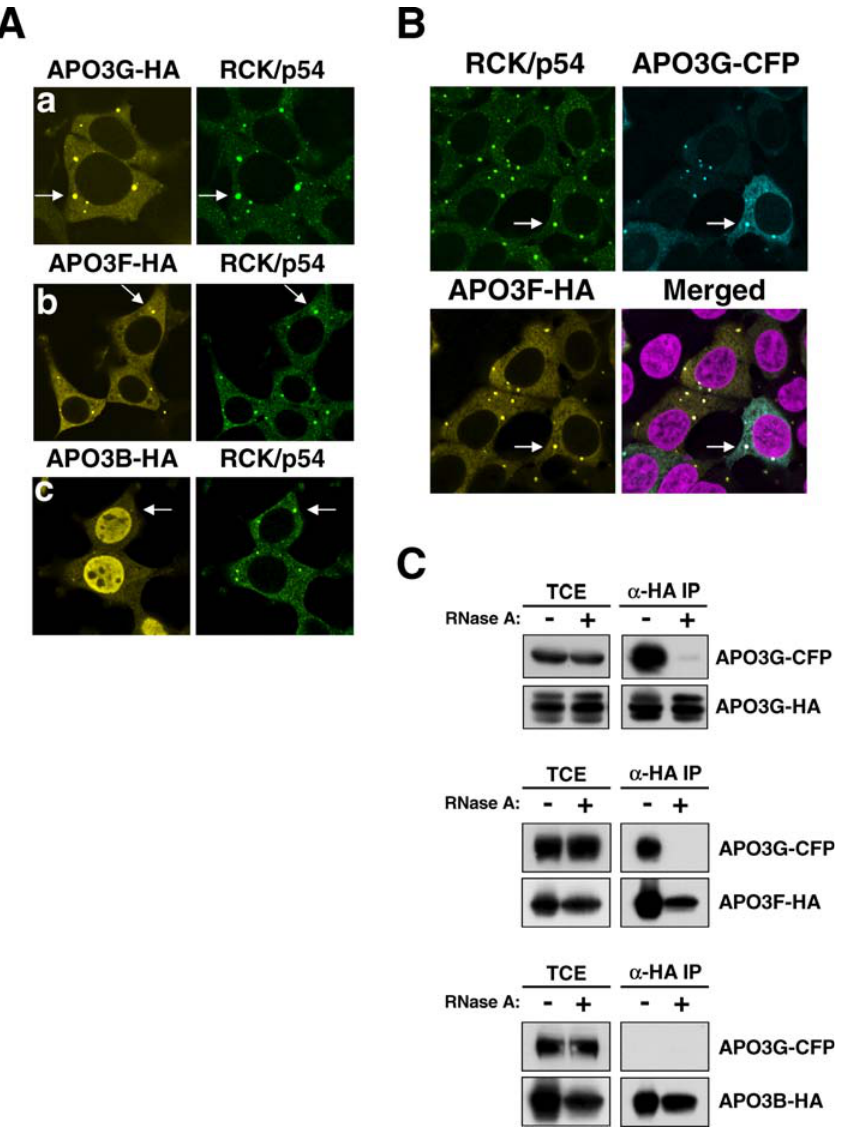
Figure 4. Potent Anti–HIV-1 Activity of APOBEC3 Proteins Correlates to P-Body Localization (A) Subcellular localization of endogenous RCK/p54 and APO3G-HA (a), APO3F-HA (b), or APO3B-HA (c) in 293T cells. Endogenous RCK/p54 was detected through indirect immunostaining with an antibody against RCK/p54 and APOBEC3 proteins with an antibody against the HA epitope. Arrows point to P-bodies. (B) Subcellular localization of endogenous RCK/p54, APO3G-CFP, and APO3F-HA in 293T cells. RCK/p54 was detected through indirect immunostaining with an antibody against RCK/p54, APO3F-HA with an antibody against the HA epitope, and APO3G-CFP was detected by direct CFP fluorescence. The cells were also stained with Hoechst 33258 to visualize nuclei and the images were digitally merged to highlight regions of colocalization, which appear white in the merged image. Arrows point to P-bodies. (C) RNA-dependent interaction of APOBEC3G and APOBEC3F. Total cell extracts from 293T cells coexpressing APO3G-CFP and APO3G-HA (top panel), APO3G-CFP and APO3F-HA (center panel), or APO3G-CFP and APO3B-HA (bottom panel) were treated with RNase A ( þ ) or vehicle alone ( (cid:1) ) and HA- tagged proteins were immunoprecipitated (IP) with a -HA agarose ( a -HA IP). Total cell extracts (TCE) and a -HA IPs were analyzed by immunoblot and APO3G-CFP was detected using an antibody against GFP while APO3G-HA, APO3F-HA and APO3B-HA were detected using an antibody against the